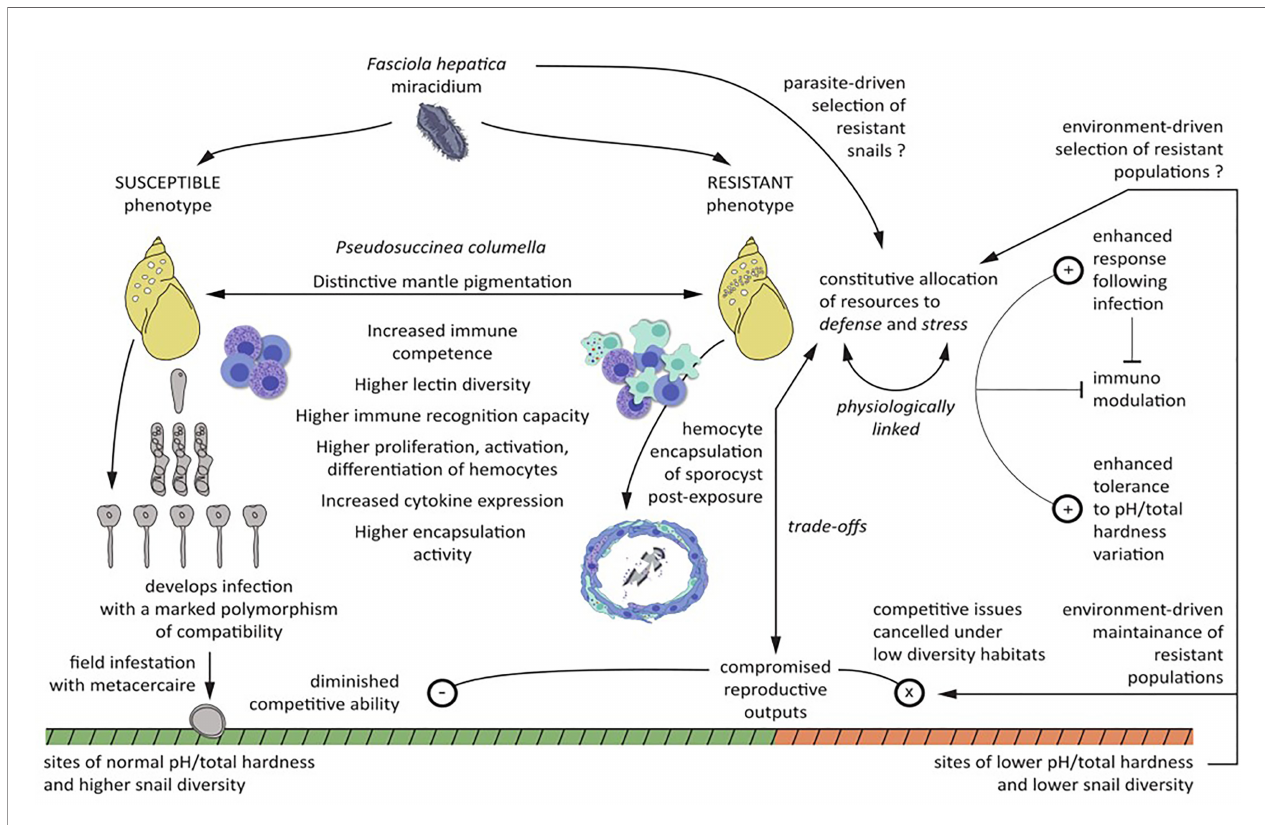
FIGURE 1 | Comprehensive view of the main phenotypic features of resistant and susceptible Pseudosuccinea columella to Fasciola hepatica and the main results and hypothesis derived from comparative molecular and mechanistic immunobiological, ecological, and evolutionary approaches applied to this system. Symbols in circles refers to enhanced (+), diminished ( − ), and canceled (x)